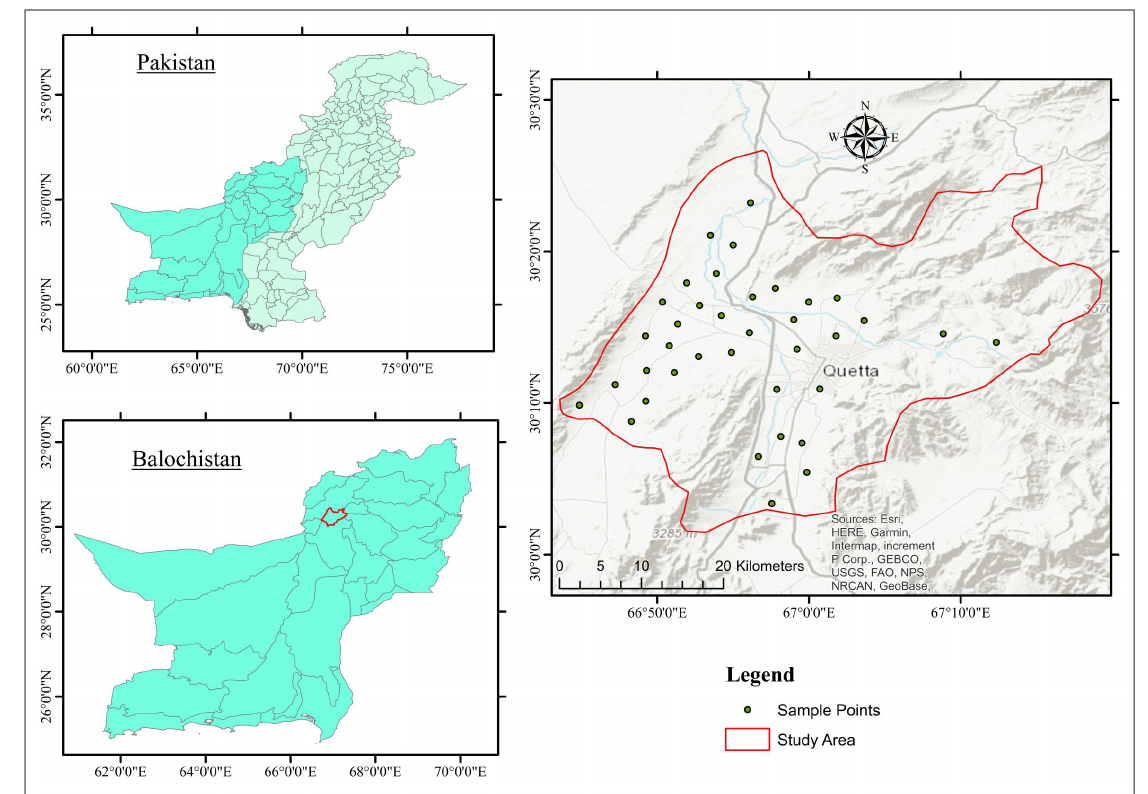
Figure 1. Location of the study area and groundwater sampling stations.